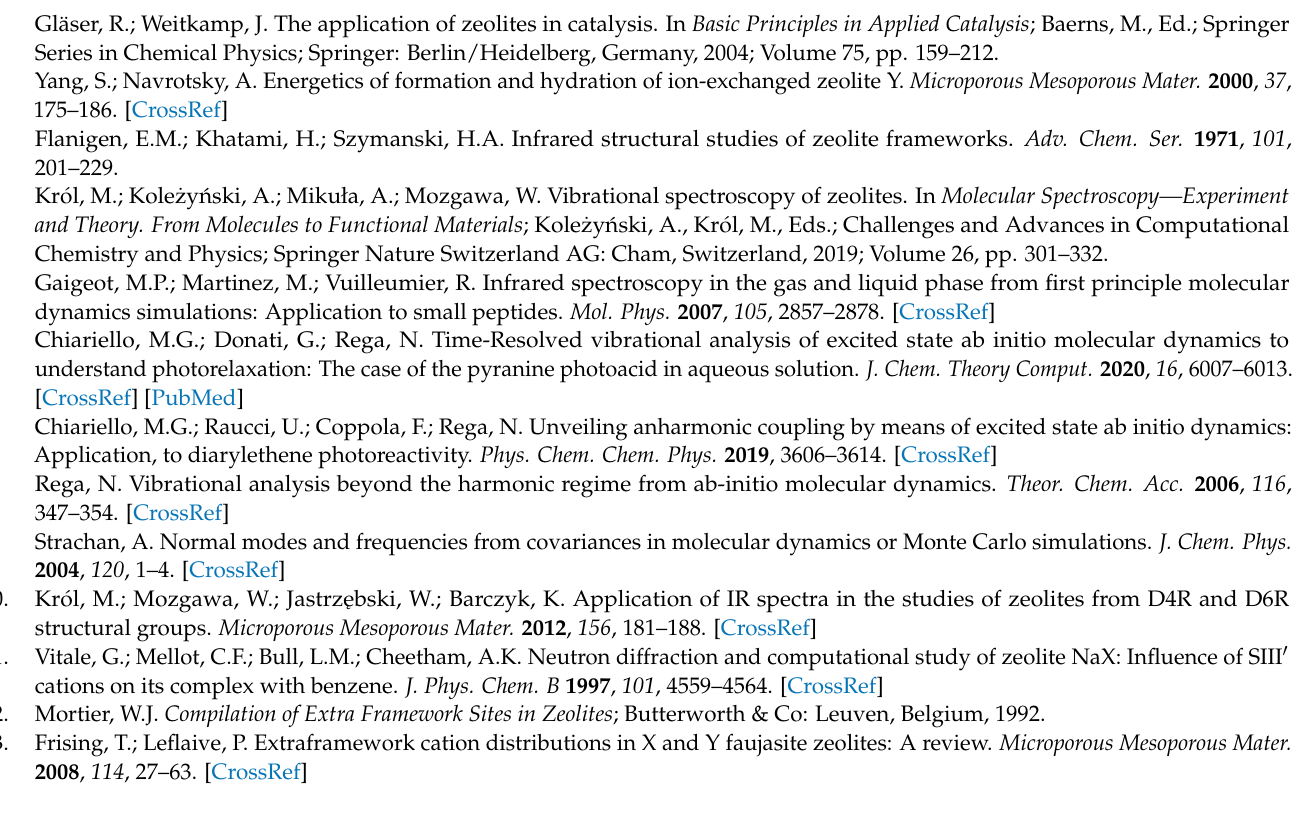
model. Figure S5: Raman spectra of FAU calculated for the “B” model. Figure S6: Raman spectra of FAU calculated for the “C”